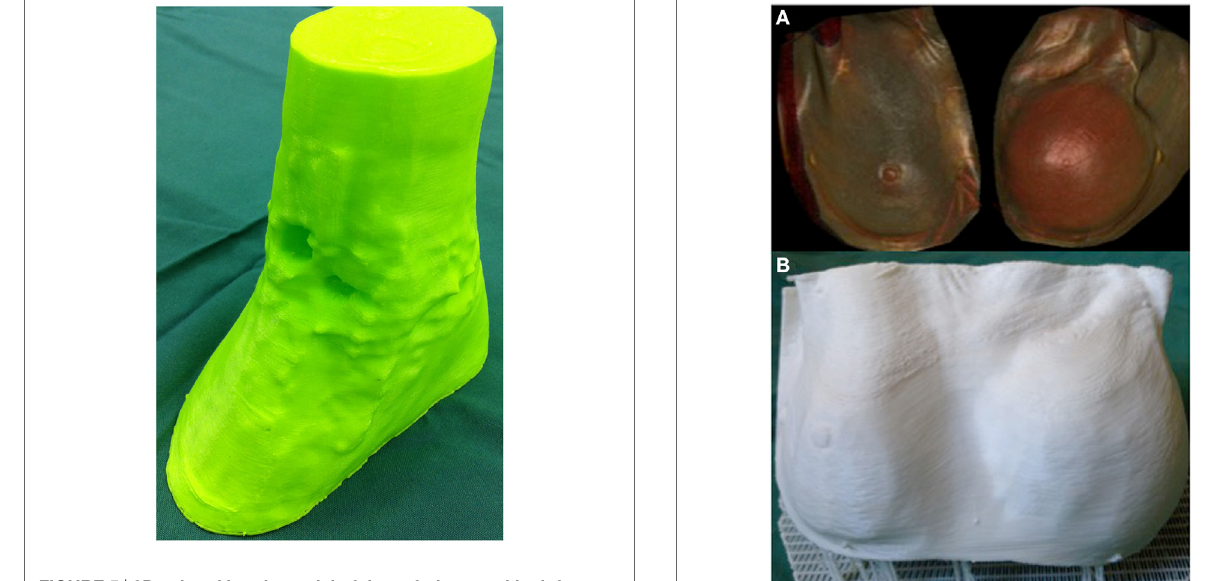
FiGURe 5 | 3D-printed haptic model of the soft tissue ankle defect . Reproduced with permission from Microsurgery (109).